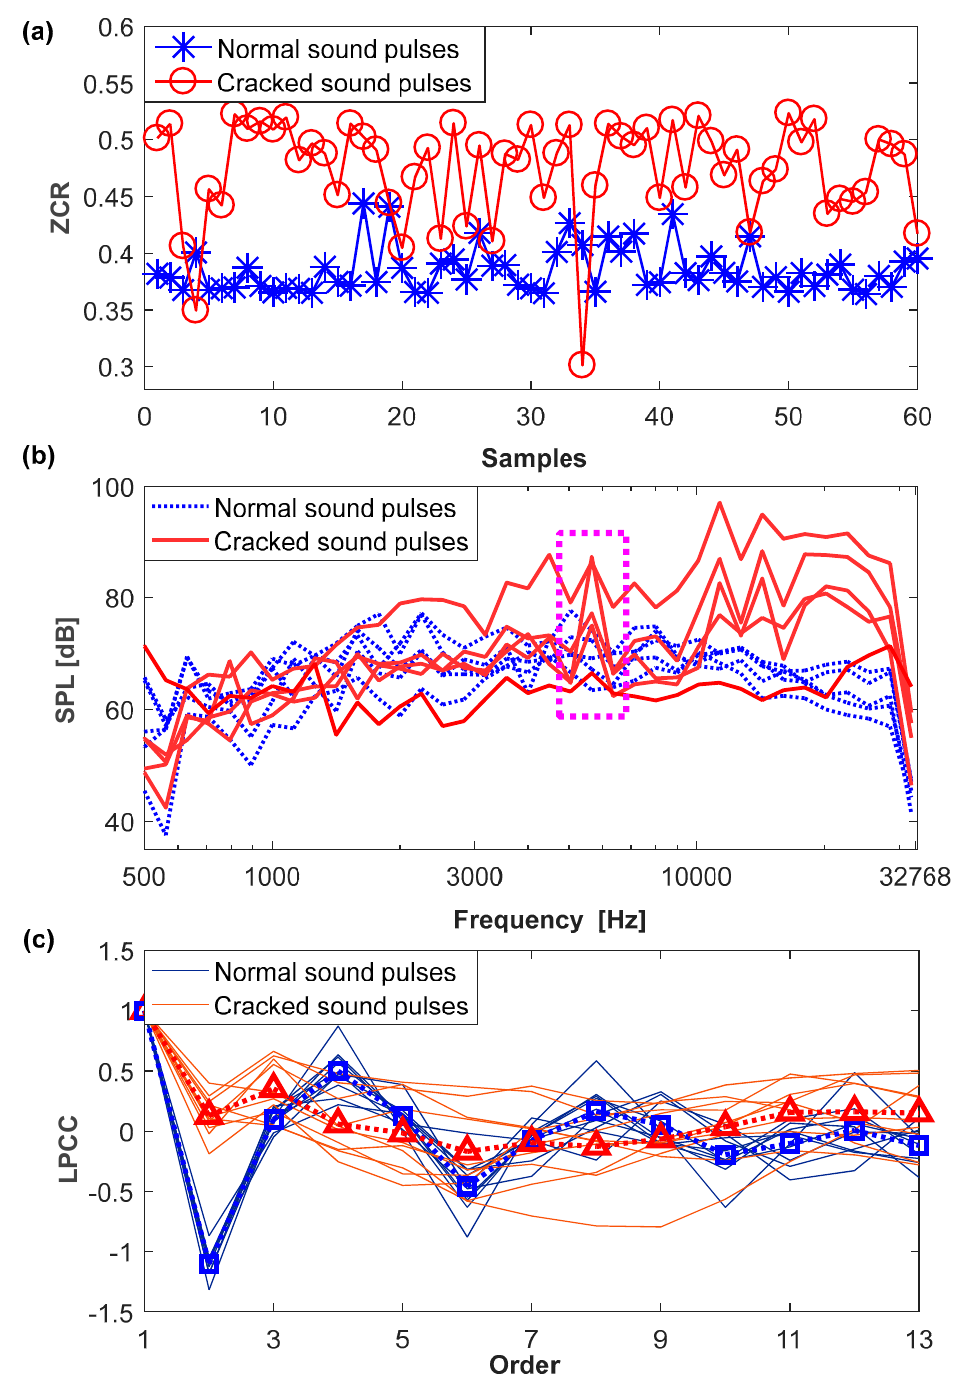
Figure 8. The results of feature extraction. ( a ) ZCR; ( b ) SPLs; ( c ) LPCCs.